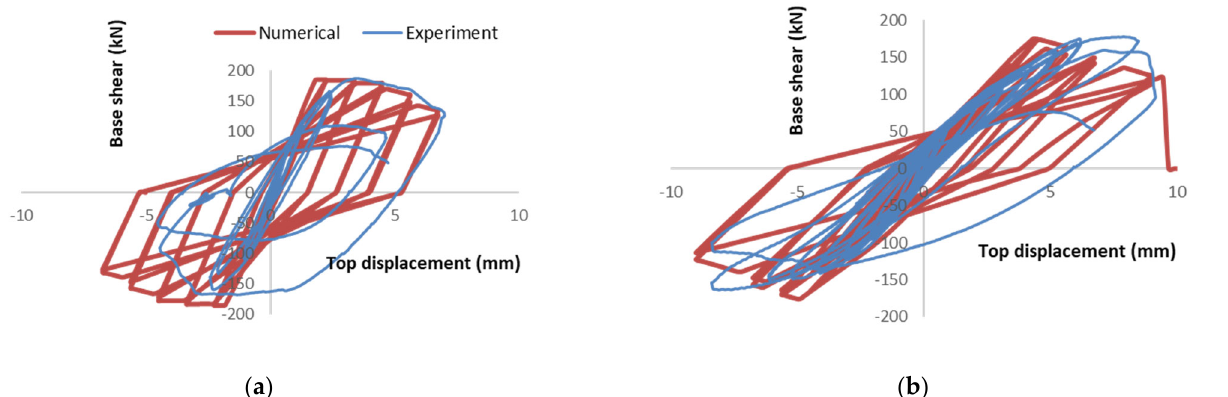
Figure 8. Displacement − force hysteresis for the numerical model and the experiment performed by Petry and Beyer [43] ( a ) PUP1, ( b ) PUP2.